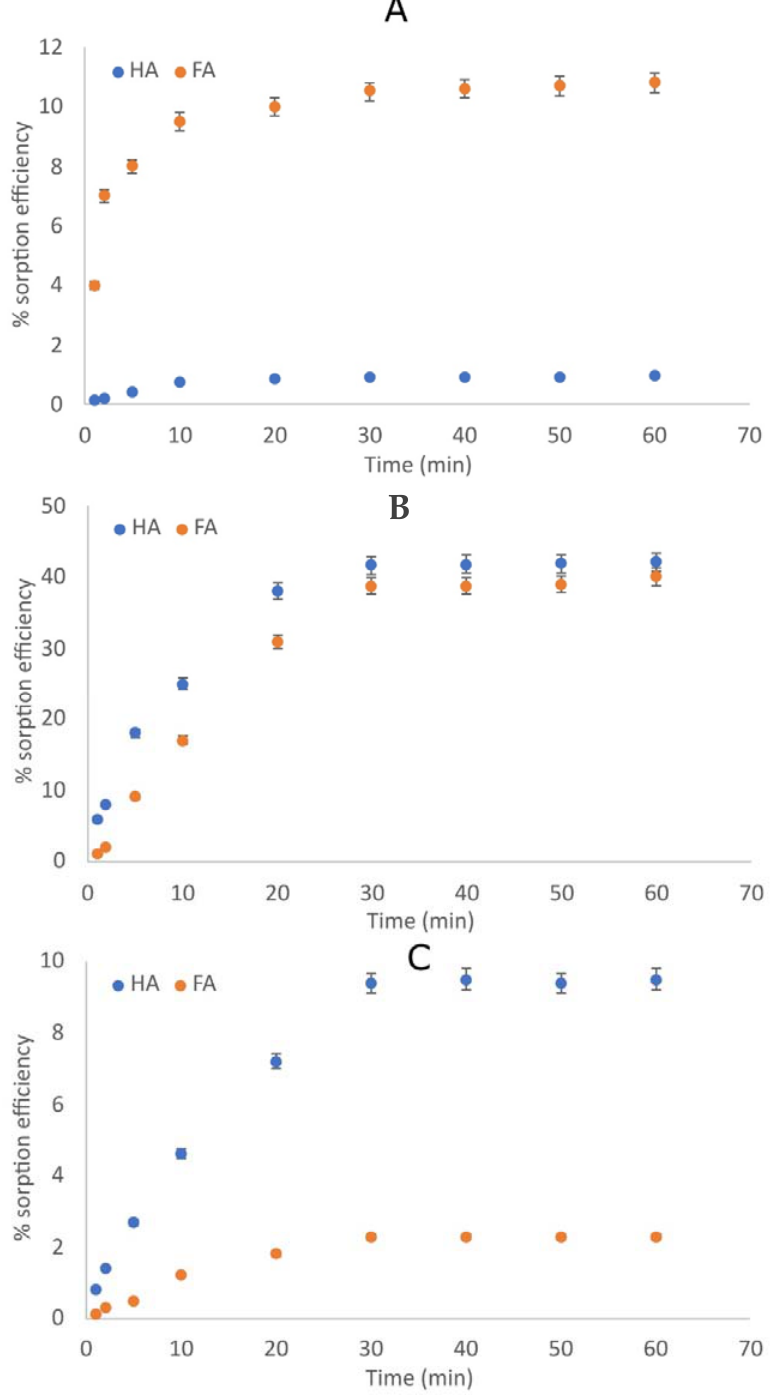
Figure 3. Kinetic study of the sorption of glyphosate ( A ), cypermethrin ( B ), and azoxystrobin ( C ) using HA and FA.